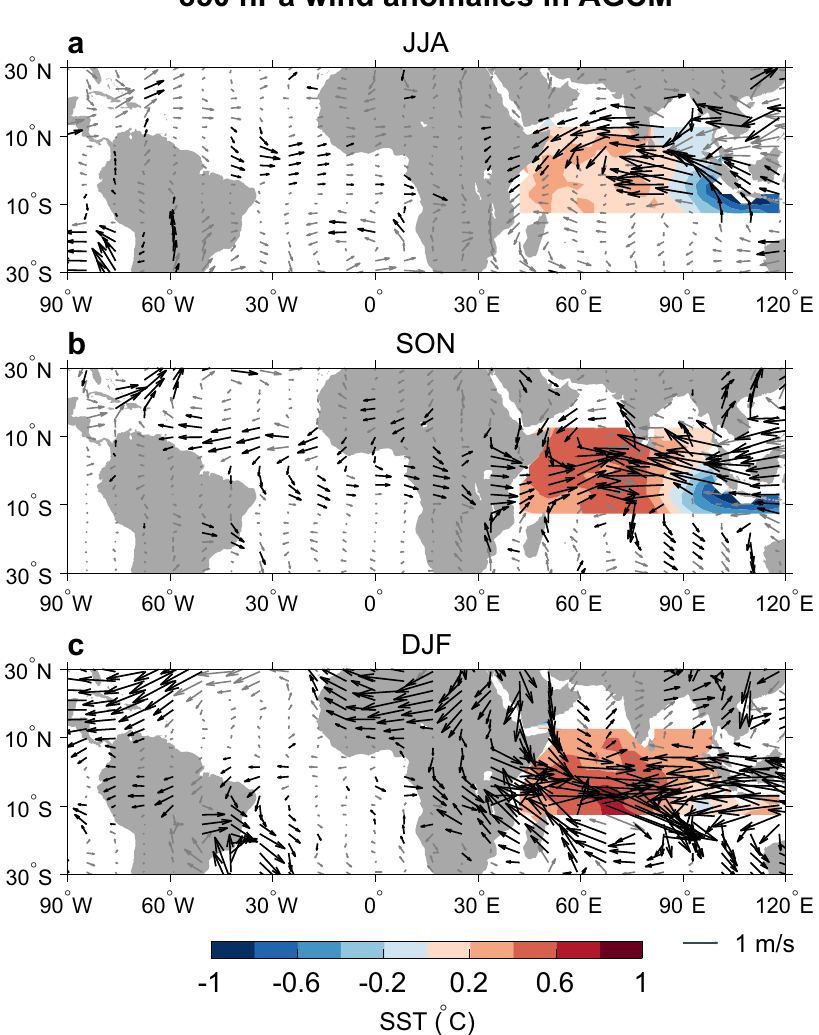
Fig. 4 Atmospheric model results forced with IOD sea surface temperature anomalies (SSTA). 850 hPa wind anomalies (vector; m s − 1 ) caused by SSTA associated with the Indian Ocean Dipole (IOD) in the atmospheric general circulation model (AGCM) experiments. a – c Anomalies averaged during June – August (JJA), September – November (SON), and December – February (DJF), respectively. Shown are differences between AGCM experiments